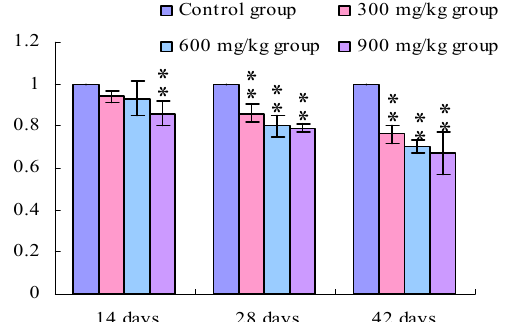
Figure 6. The TLR4 mRNA expression levels in the jejunal mucosa in broilers.